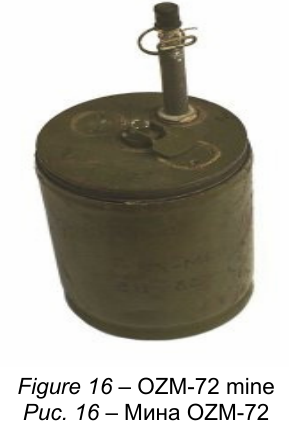
Figure 16 – OZM-72 mine Рис . 16 – Мина OZM-72 Слика 16 – Мина